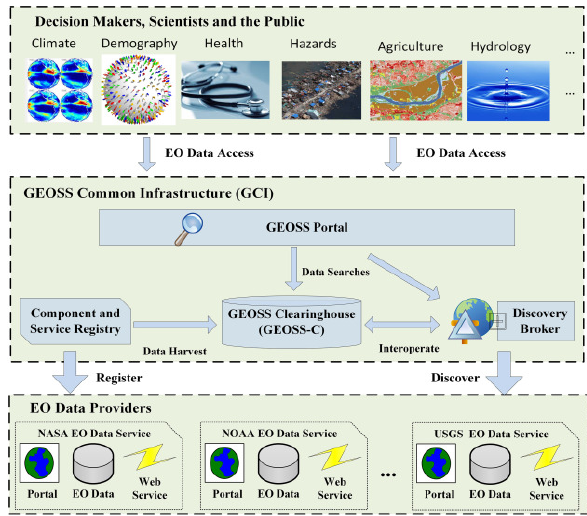
Figure 4. GEOSS Common Infrastructure model ((Xia et al., 2018))